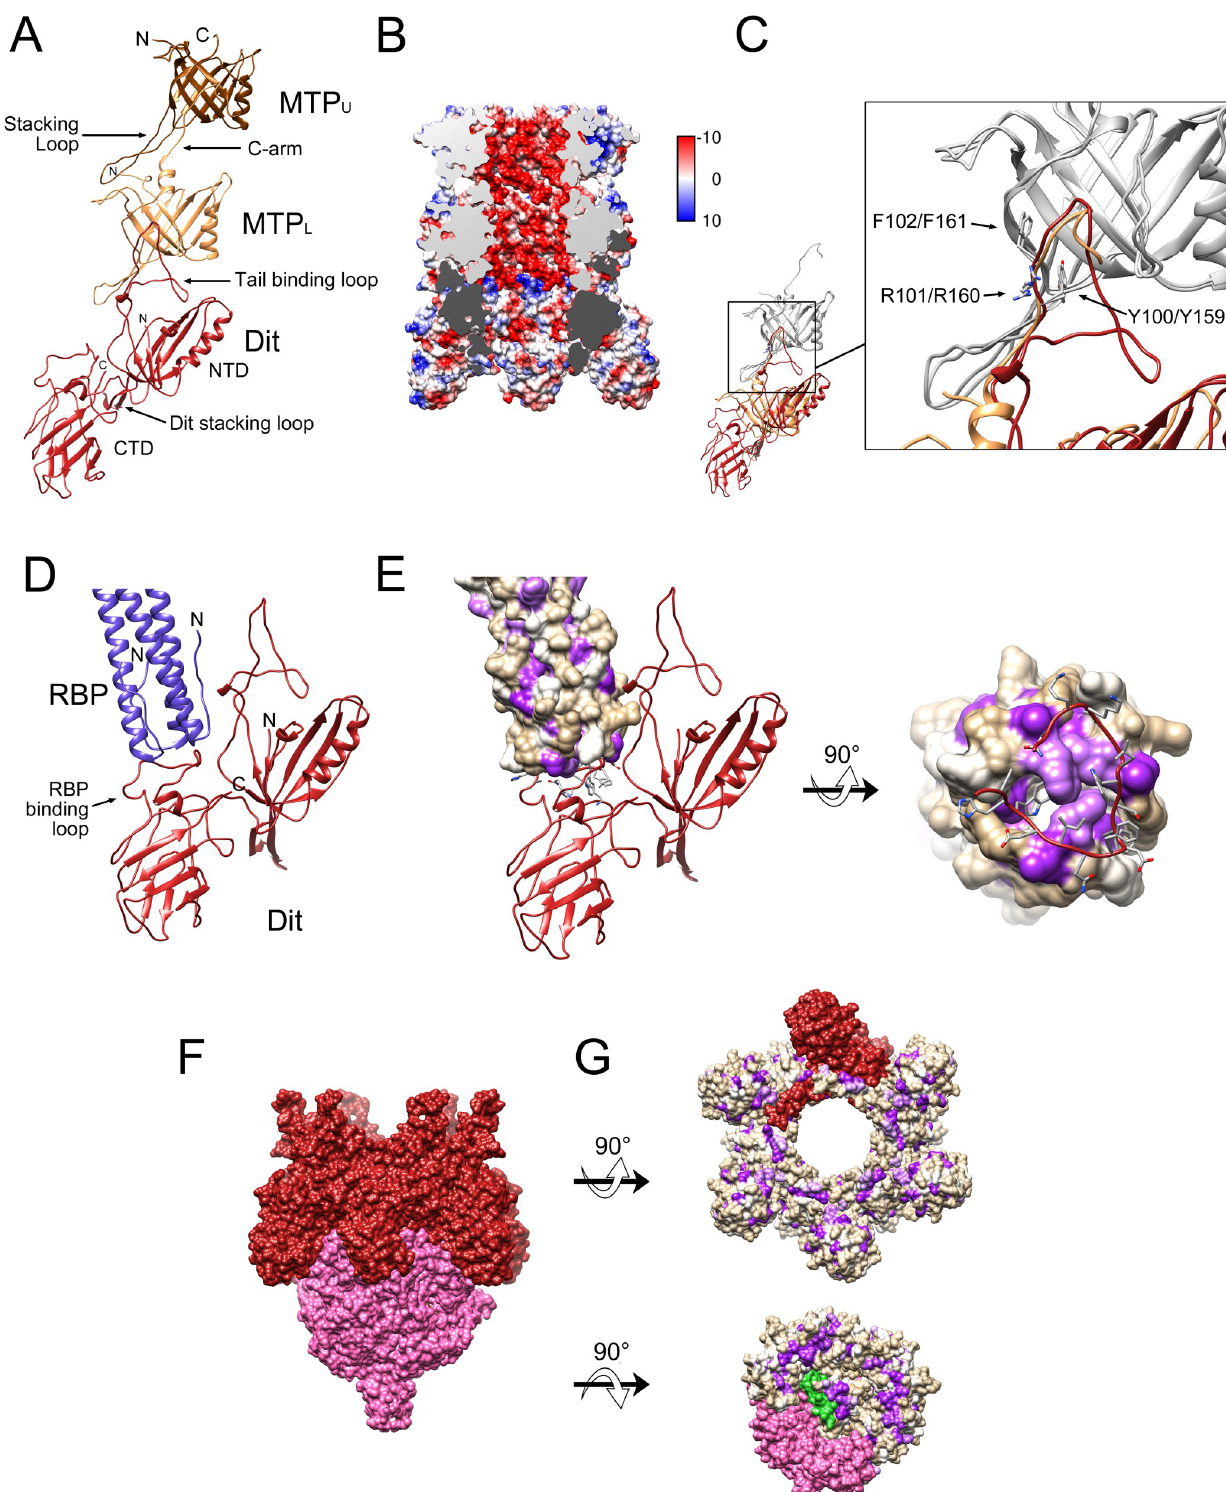
Fig 3. The baseplate core. (A) One asymmetric unit of the sixfold symmetric baseplate core, showing MTP U (brown), MTP L (tan) and Dit (red). The stacking loops of MTP and Dit, the C-arm of MTP L and the tail binding loop of Dit are indicated. (B) Cutaway electrostatic surface showing the charge distribution inside the tail, colored from red (negative) to blue (positive). The cut surfaces of MTP and Dit are colored light and dark gray, respectively.